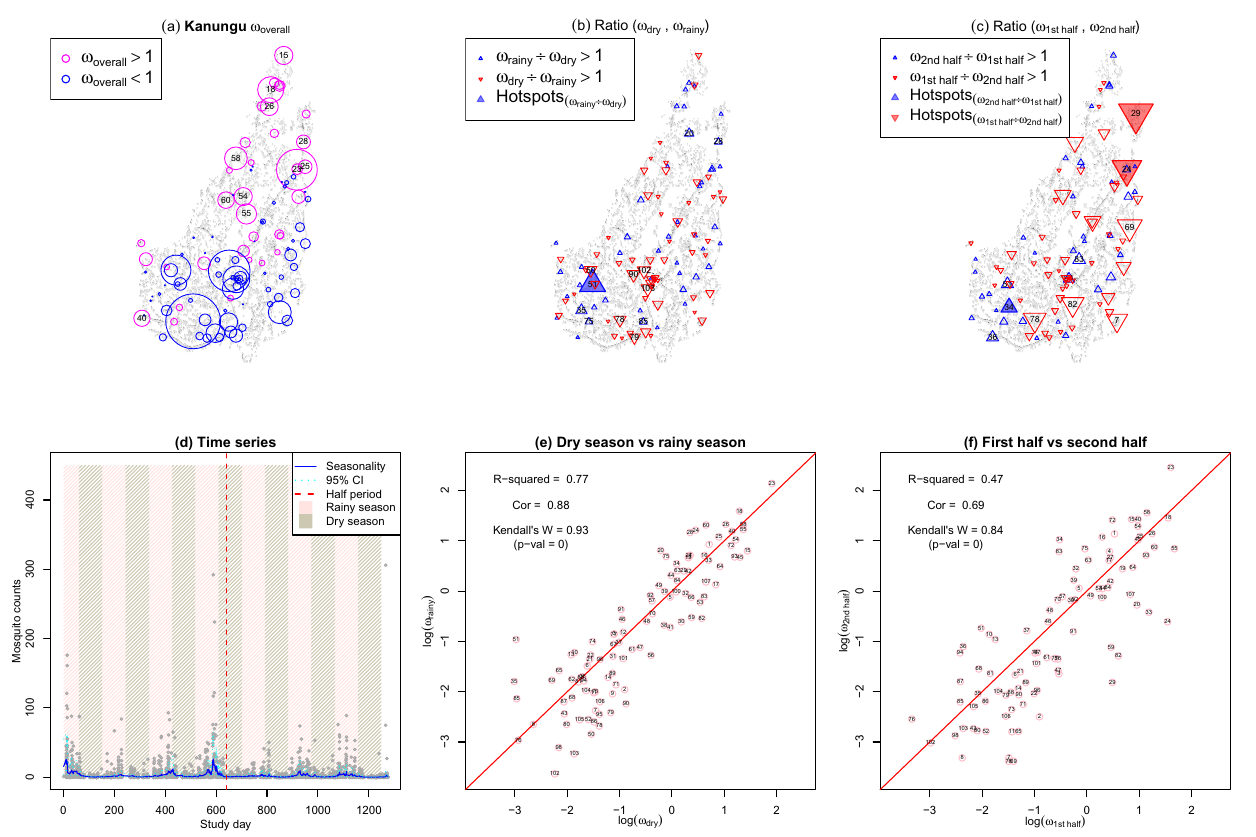
Figure 4. Kanungu. The layout of the figure is the same as in Figure 3 with some exceptions as follows. ( a ): Blue circles denote households with ω < 1 with the size of the circles showing the magnitude of 1/(5 × ω overall Households with the largest ω include HH23, HH18, and HH58. ( d ) A moderate seasonal signal was observed in overall